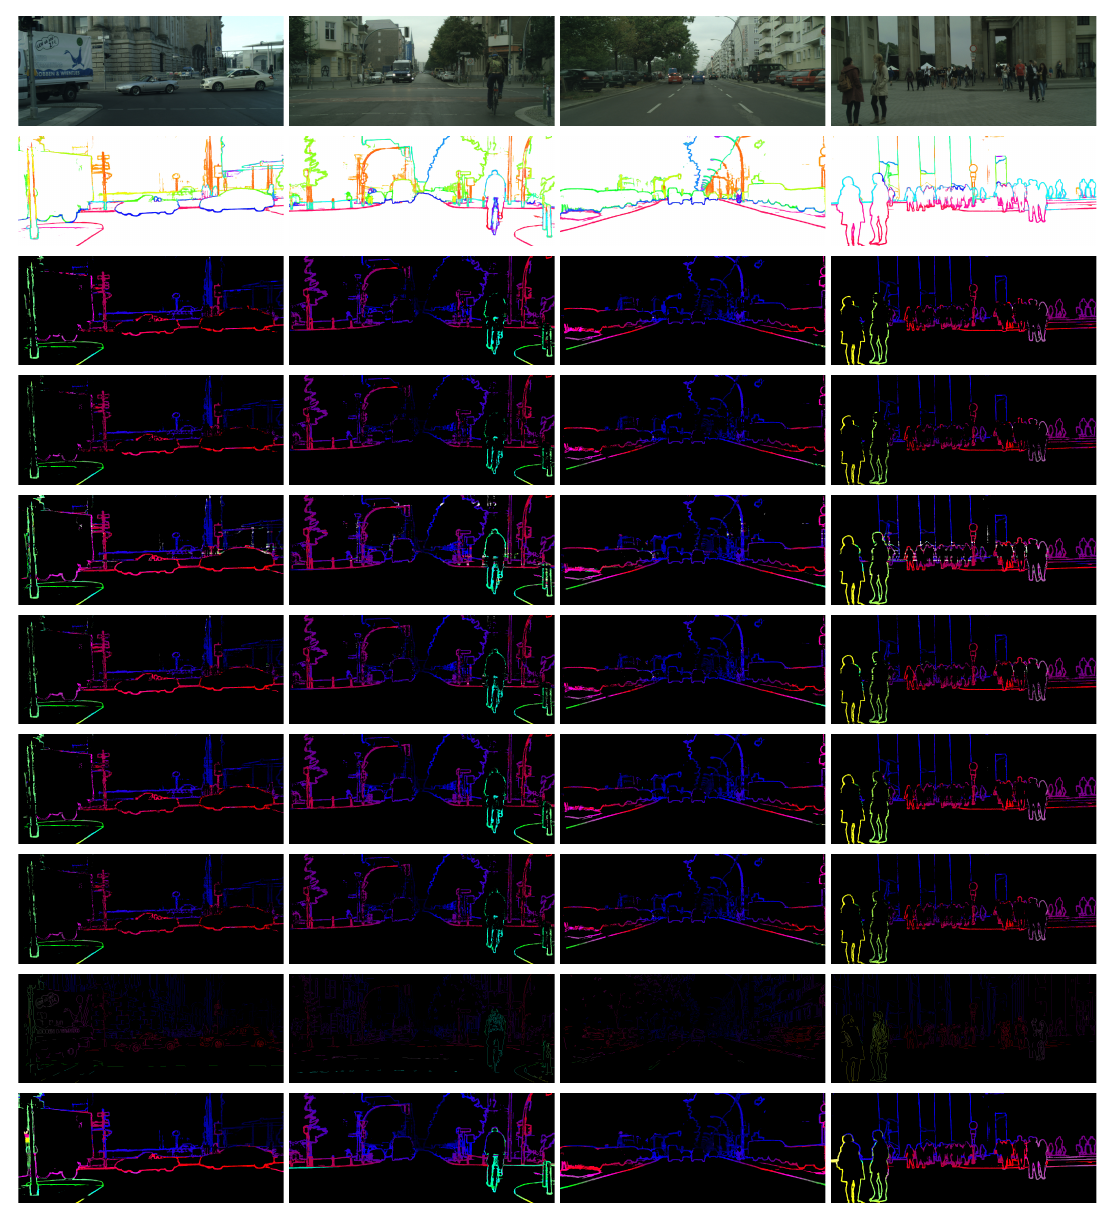
Figure 9. Examples of comparison between our method and SED [19]. From top to bottom: the left images, the semantic edges, the disparity maps of the following methods separately: SAD + ADP (LRC), SAD + ADP (SLRC), Census + ADP (LRC), Census + ADP (SLRC), SAD + 0.1Census + ADP (LRC), SAD + 0.1Census + ADP (SLRC), SED [19], SED after